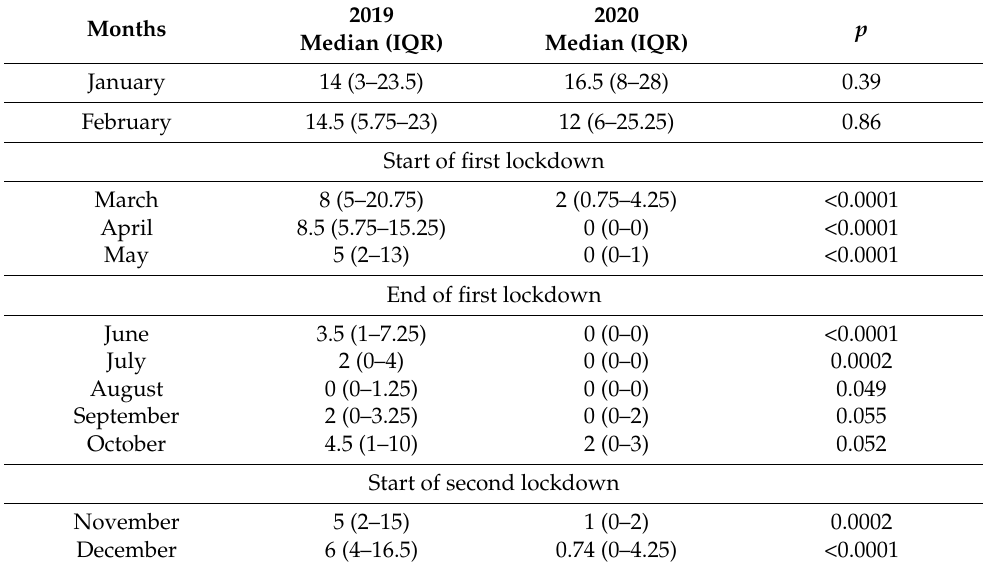
Table 3. Number of patients with pneumonia recorded monthly in 2019 compared to 2020, in the study population of 35,787 children aged 0–14 years.